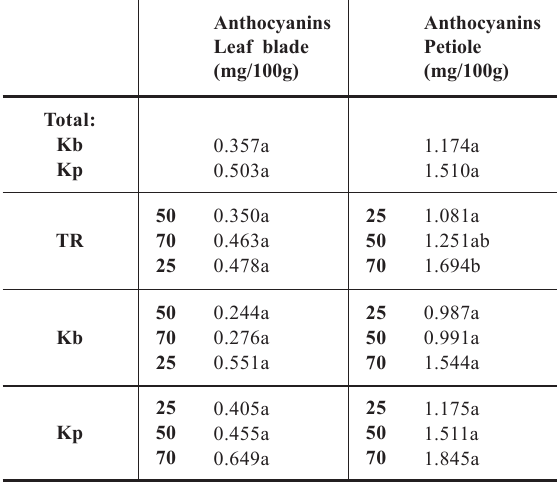
Fig. 7 - Anatomical cross sections near the midribs of the leaf blades of Kalanchoe brasiliensis (a) and Kalanchoe pinnata (b) grown under full sunlight. Arrow: Deposition of anthocyanins in the mesophyll of Kalanchoe pinnata beyond the deposition near the subjacent tissue to the epidermis in both species. Bars = 0.1mm. Total anthocyanins content in leaf blades and petioles of plots of Kalanchoe brasiliensis (Kb) and Kalanchoe pinnata (Kp) in treatments (TR) under 70% (70), 50% (50) and 25% (25) of